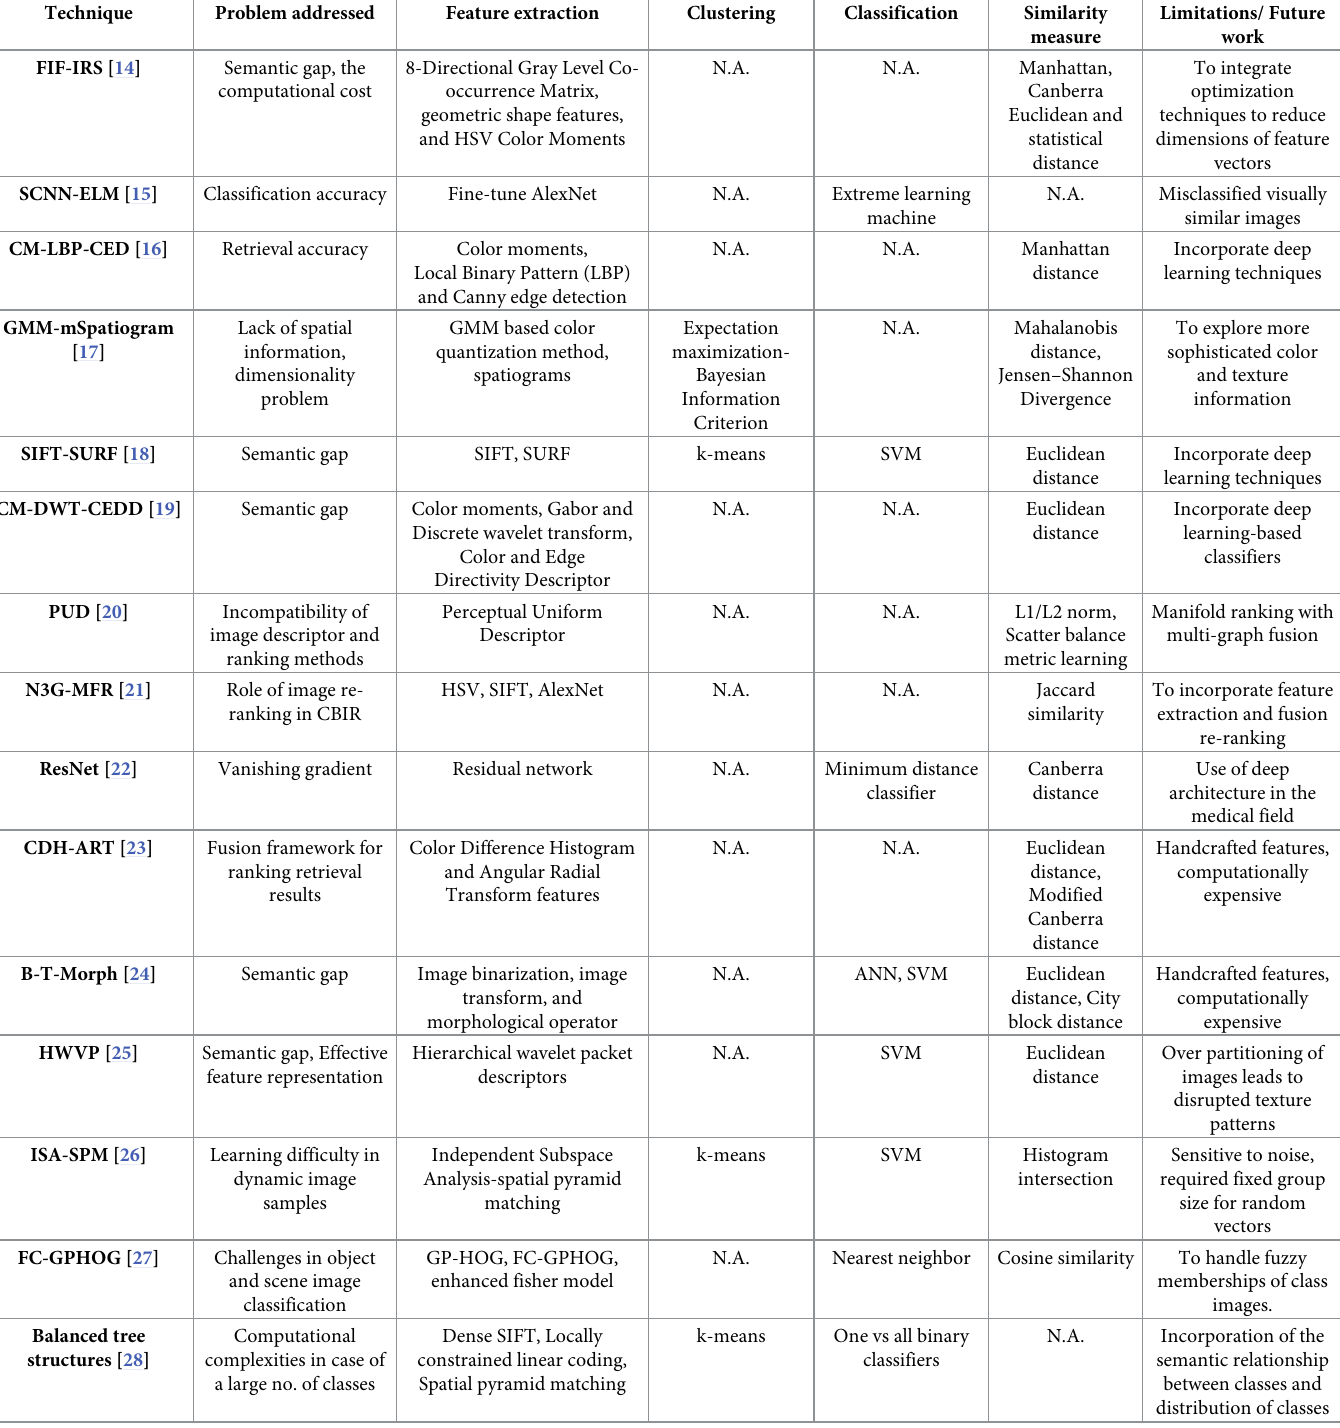
Table 1. Details of competitive CBIR